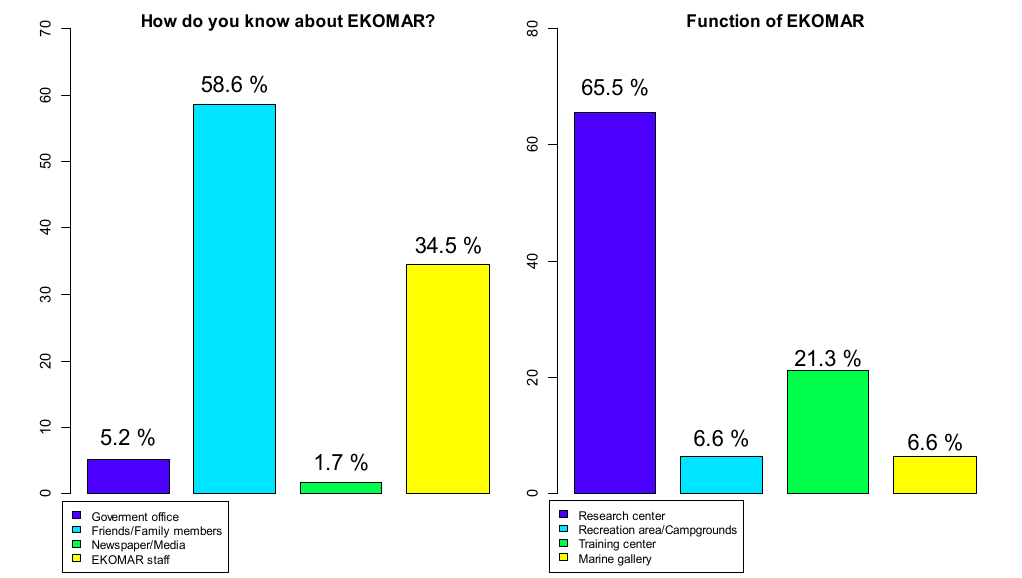
Figure 9. How the respondents find out about EKOMAR and respondents’ answers to the function of EKOMAR.